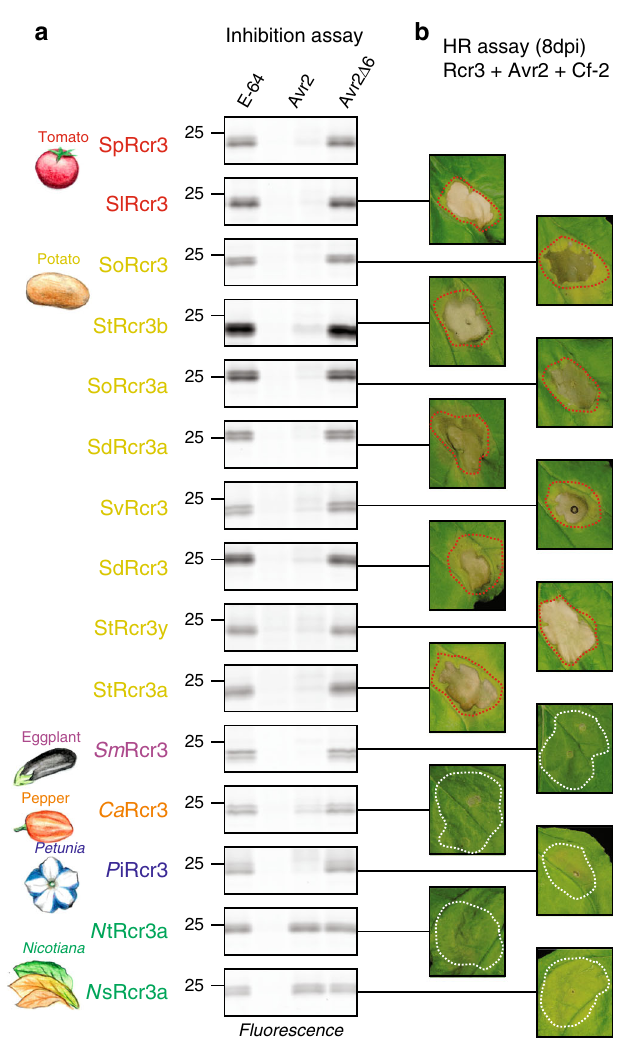
Fig. 5 Rcr3 variants are diverging on Avr2 inhibition and HR signalling. a Activity pro fi ling of Rcr3 homologs. Rcr3 homologs were co-expressed with the silencing inhibitor P19 in N. benthamiana leaves by agroin fi ltration. Apoplastic fl uids were isolated at 2 dpi, preincubated for 45 min with or without 100 µ M E-64, 4 µ M Avr2 or Avr2 Δ 6, or DMSO, and labelled for 3 h with 2 µ M MV201. Samples were separated on SDS-PAGE gels and scanned for fl uorescence. b Tomato and potato Rcr3 homologs can trigger a HR, while the pepper, eggplant, Nicotiana and Petunia Rcr3 homologs do not trigger responses. Rcr3 homologs were co-expressed with Avr2 and Cf- 2 by mixing Agrobacterium cultures (OD 600 = 0.25 each) in a 1:1:1 ratio. Pictures were taken at 8